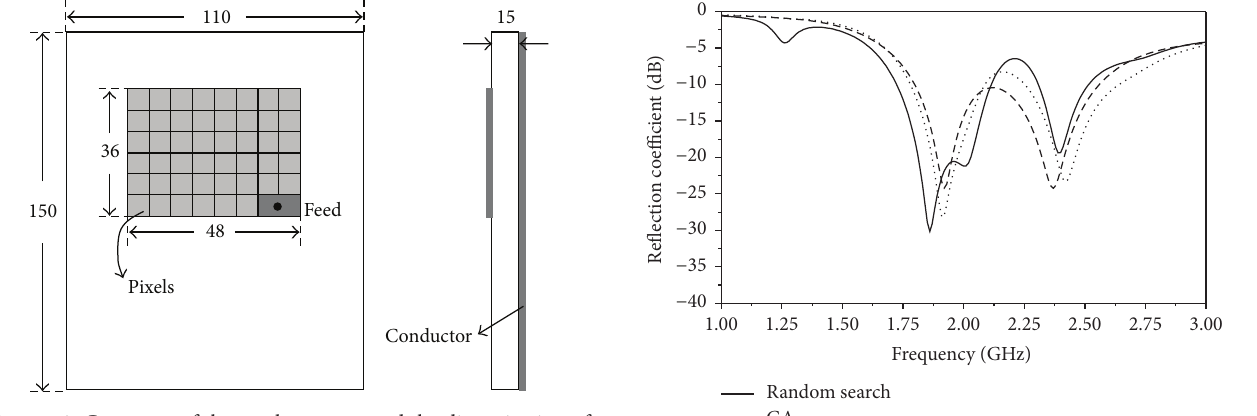
Figure 2: Geometry of the patch antenna and the discretization of the design space (unit: mm).